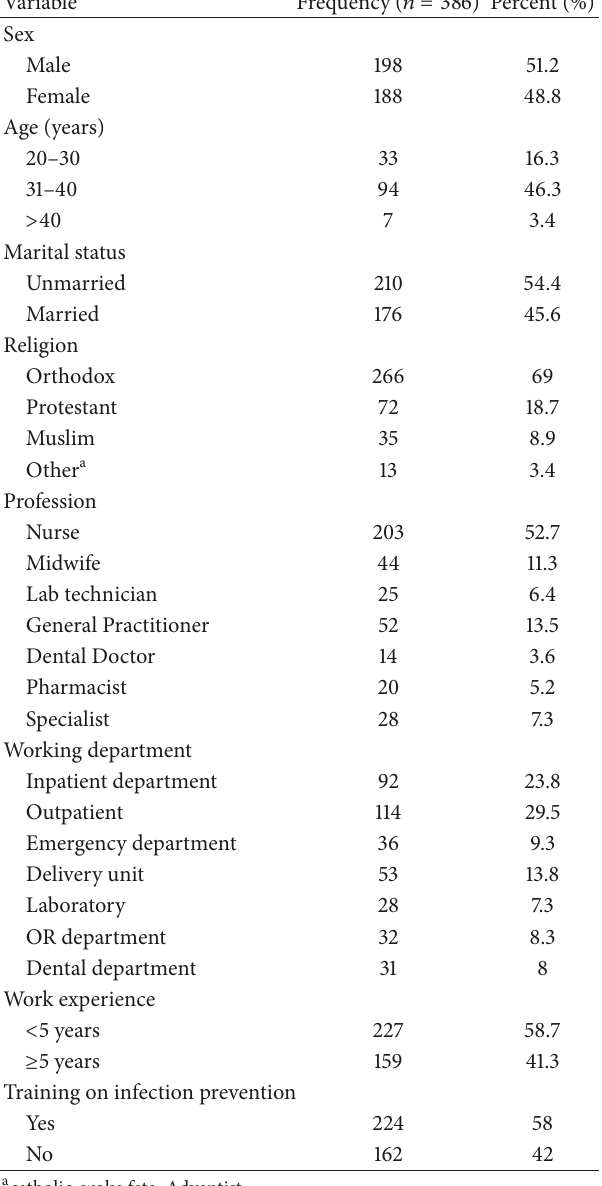
Table 1: Socio-demographic characteristics of health professionals, AHMC, Ethiopia